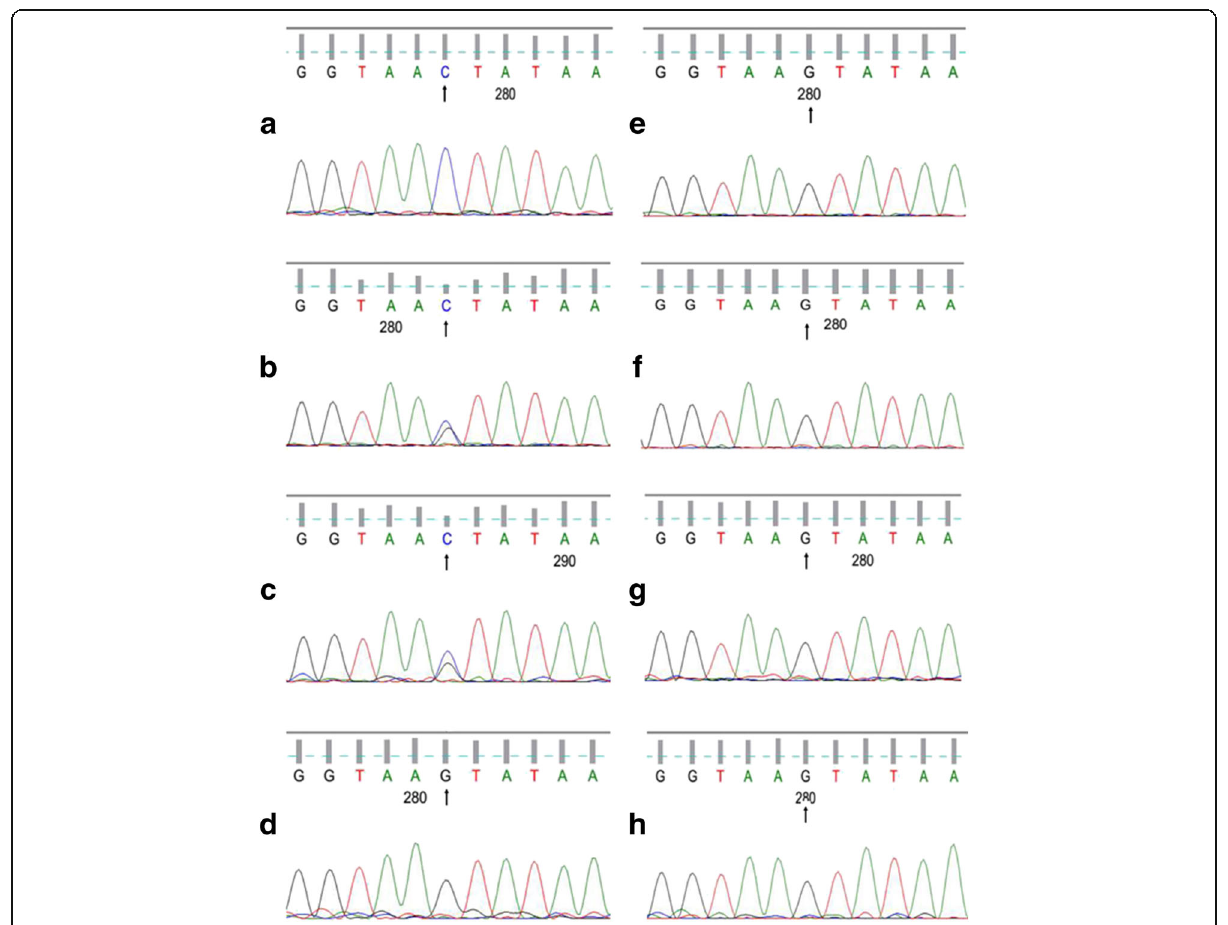
Fig. 6 Gene sequencing of CYBB. The patient and his sister and mother have c. 141 + 5G > C mutation in CYBB gene. The other relatives are normal. Arrows indicate the mutation points. a the patient. b the patient ’ s sister. c the patient ’ s mother. d the patient ’ s father. e the patient ’ s paternal aunt. f the patient ’ s maternal uncle. g the patient ’ s paternal grandmother. h the patient ’ s maternal